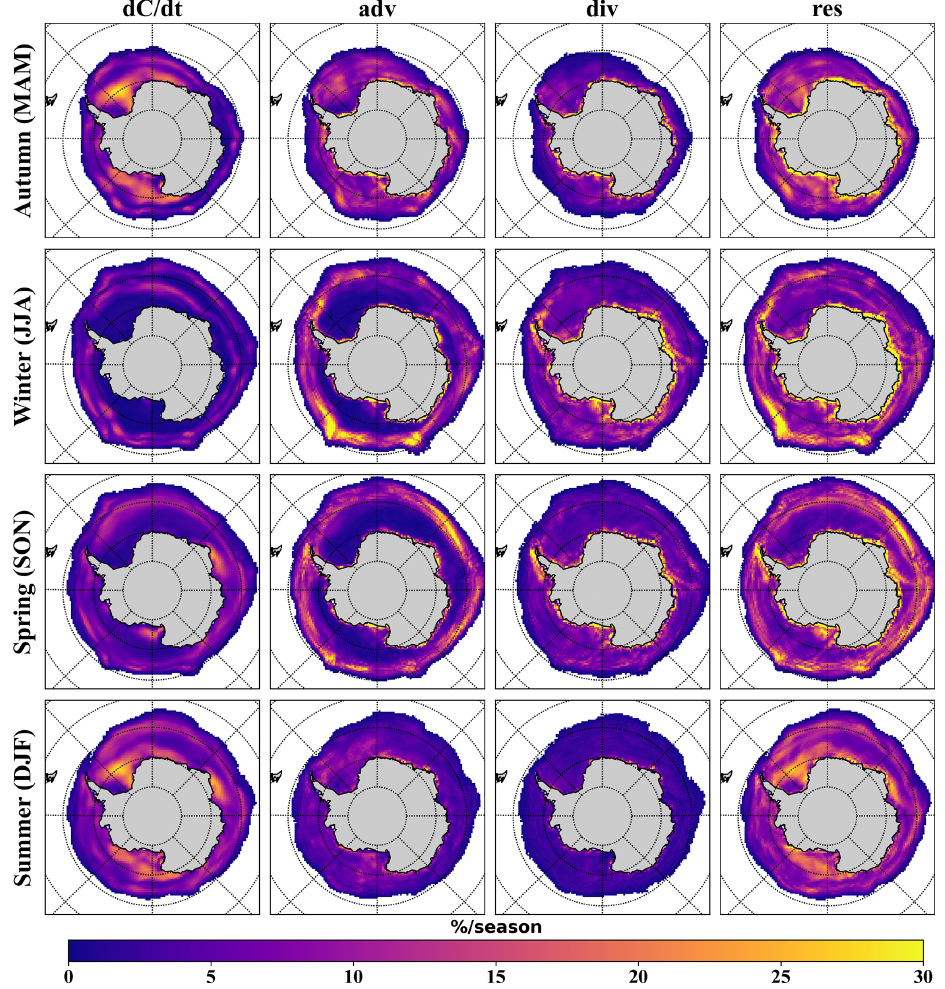
Figure 4. Standard deviation of seasonal SIC budget components for the ensemble of 449 model runs. The maximum value of the colour map is limited to 30% per season for the best presentation. A higher percentage value means that the model ensemble is more divergent